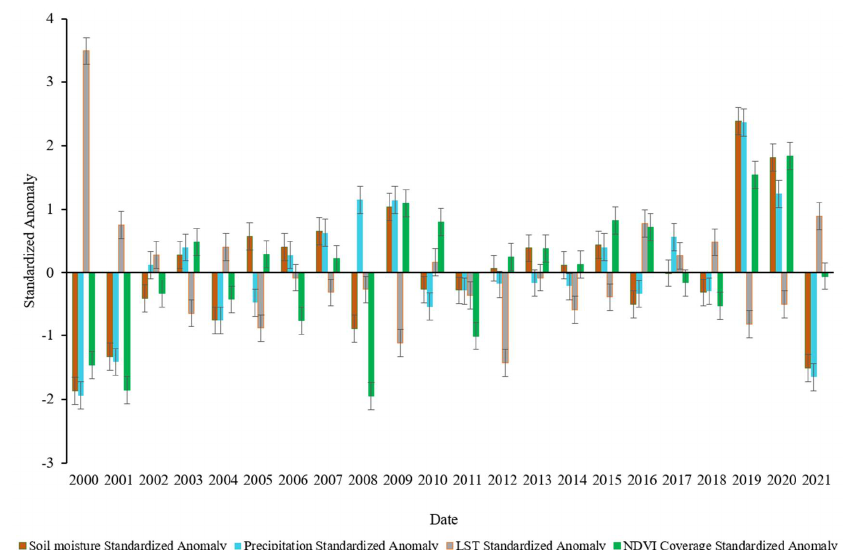
Figure 11. Time series of the standardized annual anomalies of LST, precipitation, vegetation coverage, and soil moisture in Afghanistan in the period 2000–2021.